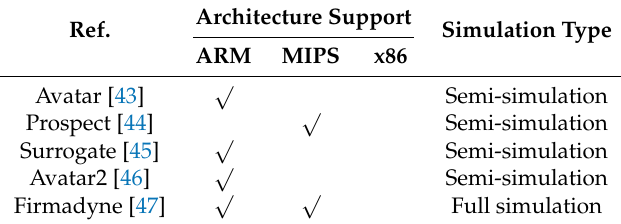
Table 1. This table is a summary of the basic framework of vulnerability analysis. Semi-simulation = The framework needs to rely on the real-world device to receive forwarded I/O access.